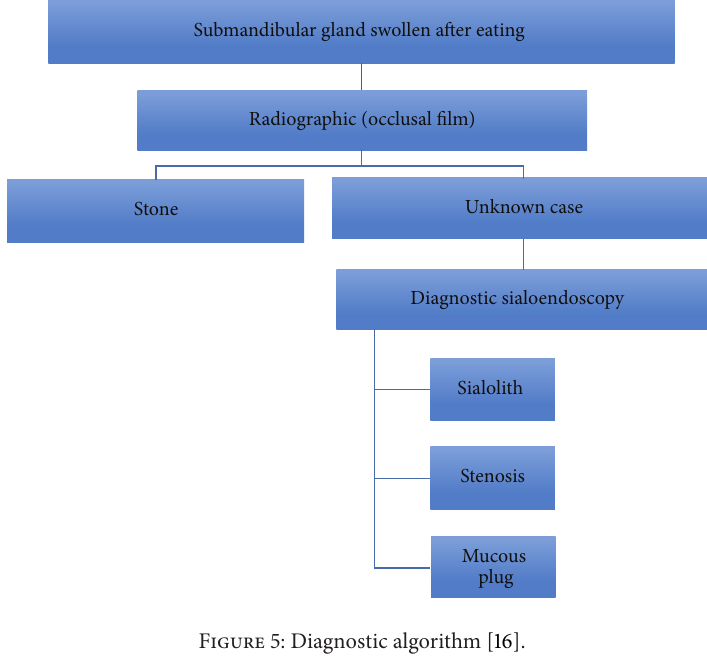
Figure 5: Diagnostic algorithm [16].